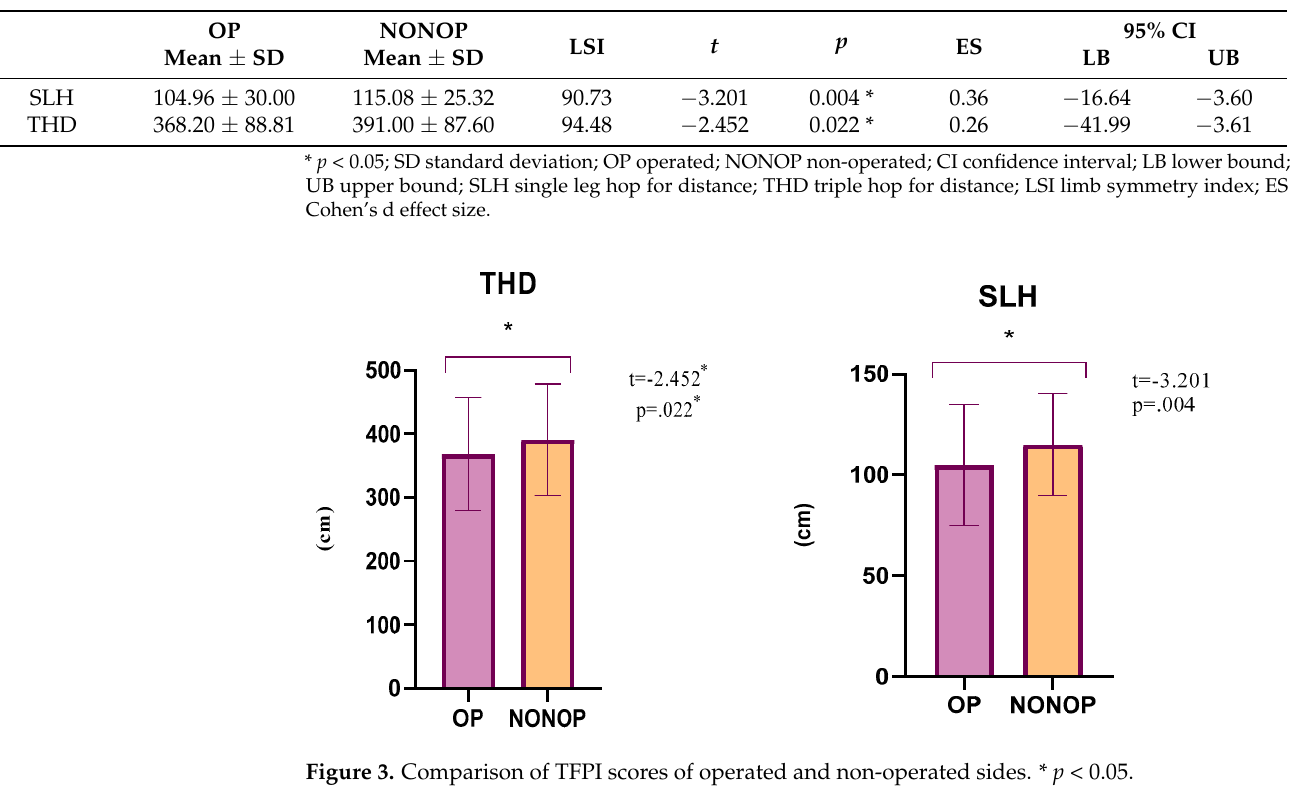
Table 4. Comparison of single leg hop and triple hop distance test results of operated and non- operated sides.